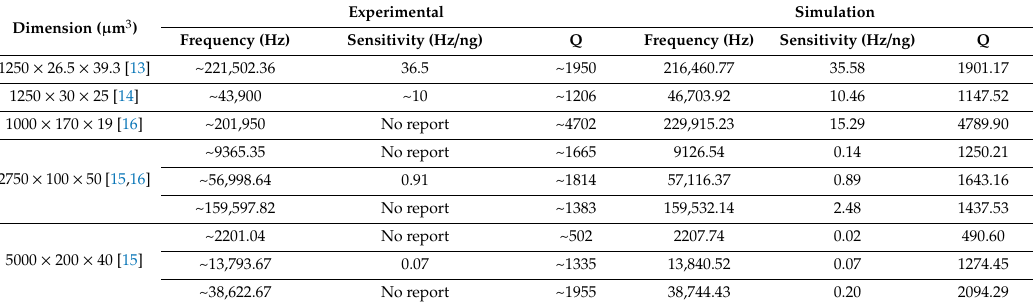
Table 2. The performance parameters of experimental and